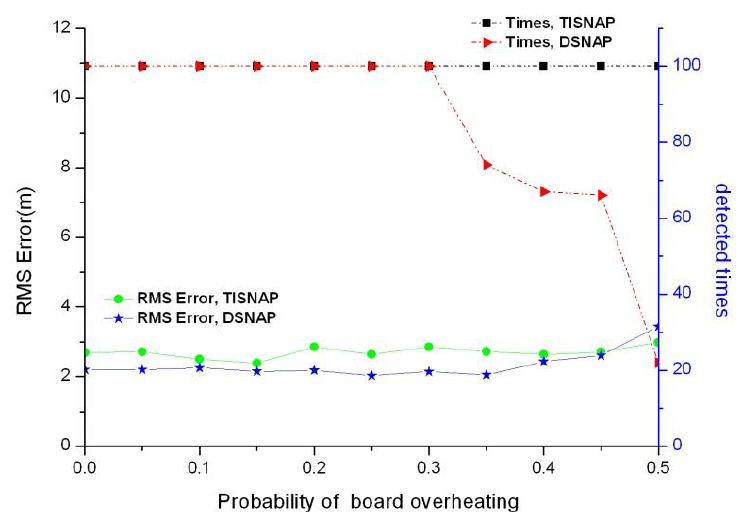
Figure 8. Estimator performance versus probability of